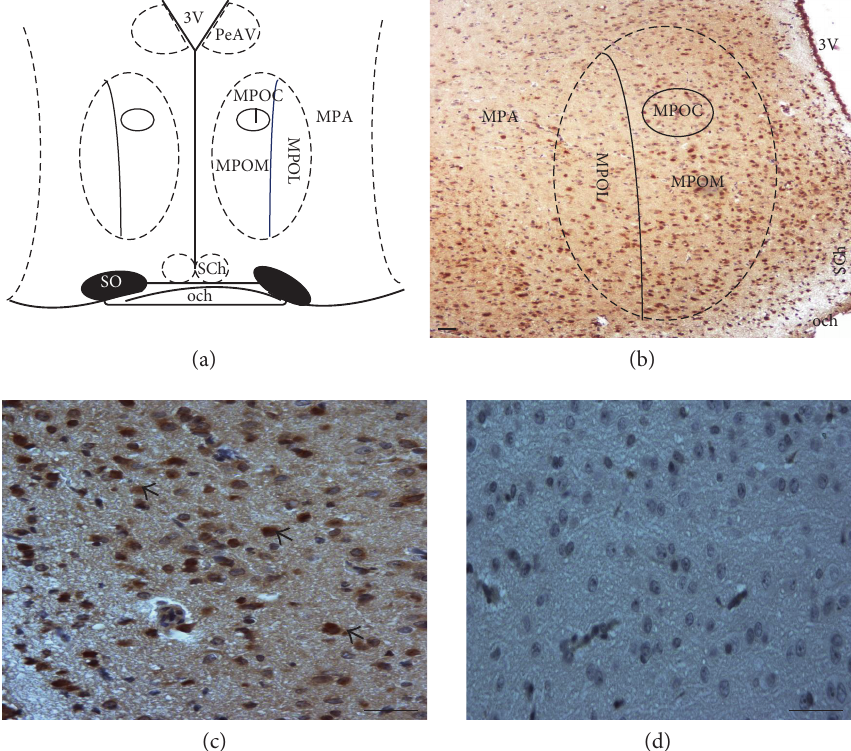
Figure 1: A representative diagram of the POA-AHA region shows the site of microinjections and where cell counting was performed. The diagram is based on the Paxinos and Watson ’ s stereotaxic atlas for the rat brain (a). Representative photomicrographs showed the immunoreactive neurons (brown) for m AChR of intact rats on the right side of the POA-AHA, where cells were counted within the central, 2 lateral, and medial portions of the medial preoptic nucleus, magni fi cation 10x (b) and 40x (c); arrowheads show the immunostained (cytoplasmic) neurons in the POA-AHA region. Negative control, magni fi cation 40x (d). Scale bar =50 μ m. See Section 2 for details. MPA, medial preoptic area; MPOM, medial part of medial preoptic nucleus; MPOL, lateral part of medial preoptic nucleus; MPOC, central part of medial preoptic nucleus; PeAV, paraventricular nucleus; 3V, third ventricle; SCh, suprachiasmatic nucleus; SO, supraoptic nucleus; och, optic